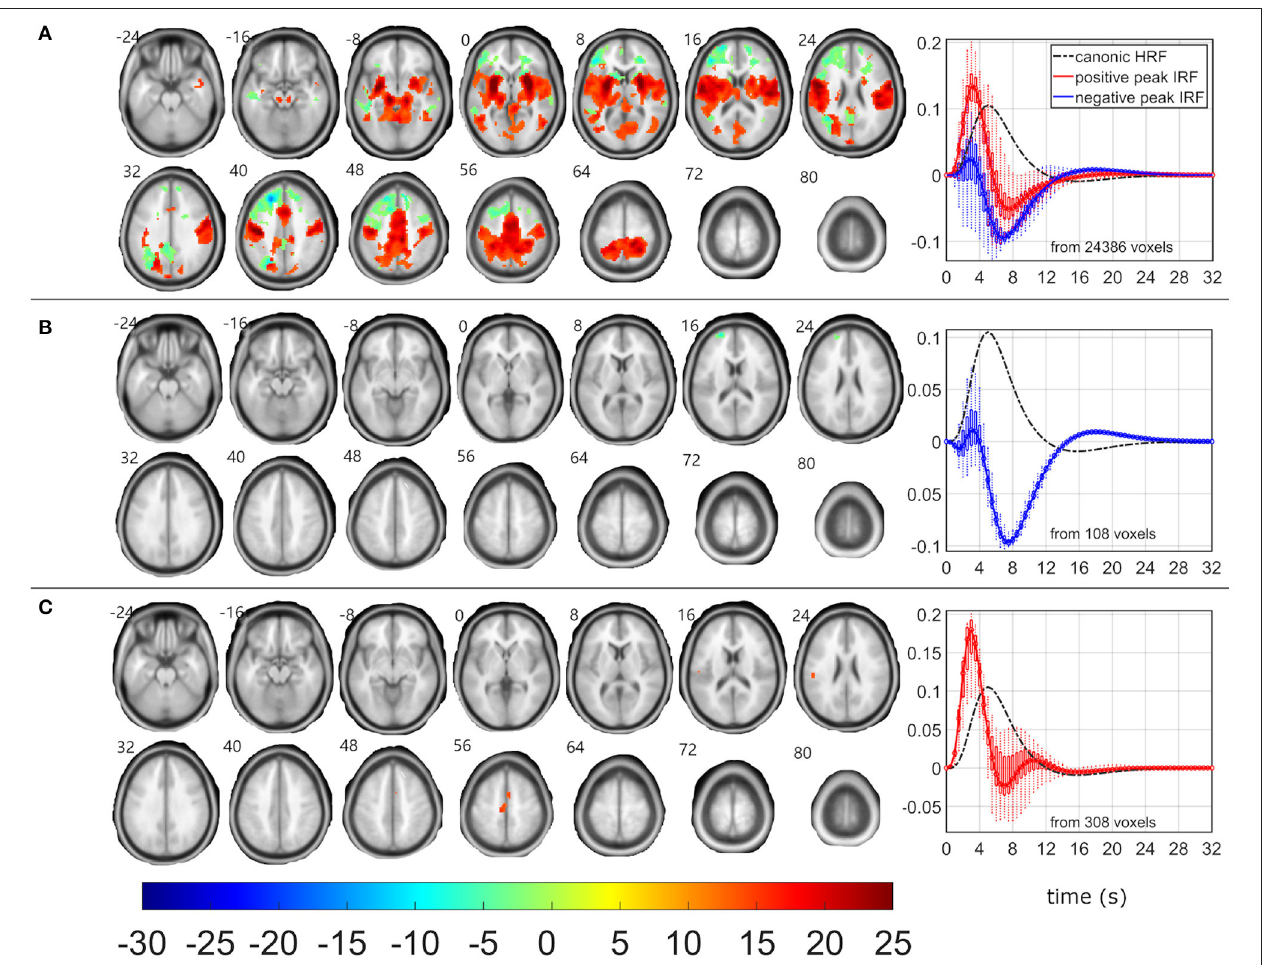
FIGURE 6 | EEG-fMRI F-maps and estimated hemodynamic response functions for all investigated models of the δ 3 pattern. The EEG-fMRI F-map colorbar is the same over all models. HRF, hemodynamic response function; IRF, impulse response function. If HRF demonstrated a reduced peak and an amplified trough (i.e., blue color-coded HRFs) the F -values were assigned with a negative sign. The F-maps were threholded with p < 0.0001, i.e., |F| > 8.1. The voxels with |F| > 12.1 met the condition p FWE < 0.05. The red color coded HRFs were derived from voxels with positive signed suprathreshold F -values. All F-maps are shown following the neurological convention, i.e., left hemisphere on the left side of the axial slice. (A) Absolute spectral. (B) Relative spectral. (C) Absolute spatiospectral. (D) Relative